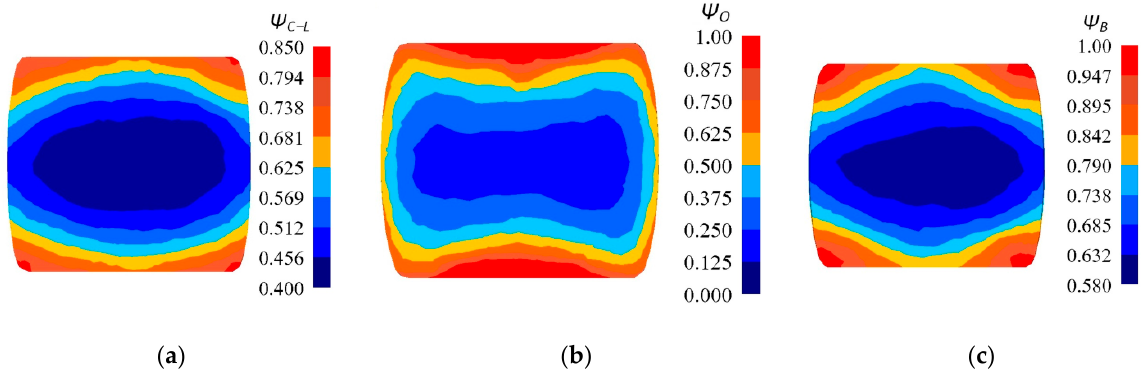
Figure 19. Distribution of the damage factors: ( a ) Cockcroft and Latham, ( b ) Oyane et al., and ( c ) Brozzo et al. after eighth pass of the forging with a concave cross-section in flat anvils ( α c = 150°, ε c = 0.356, forging ratio 4.2).